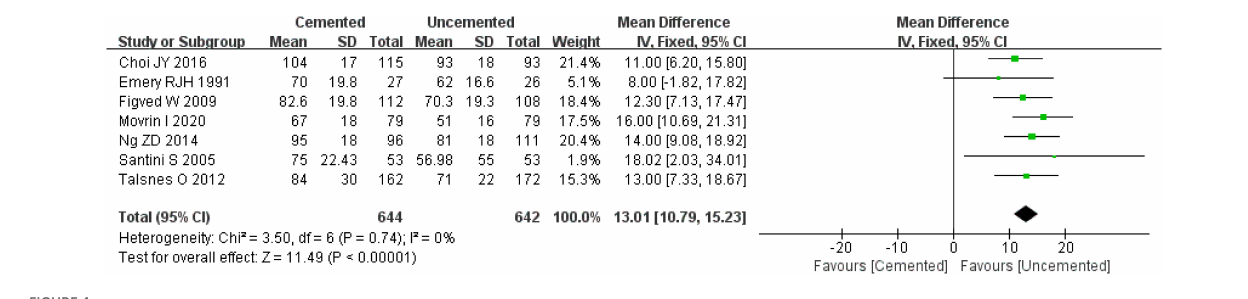
FIGURE4 Forest plot for comparison of operation time between cemented bipolar hemiarthroplasty (CBH) group and uncemented bipolar hemiarthroplasty (UCBH) group.